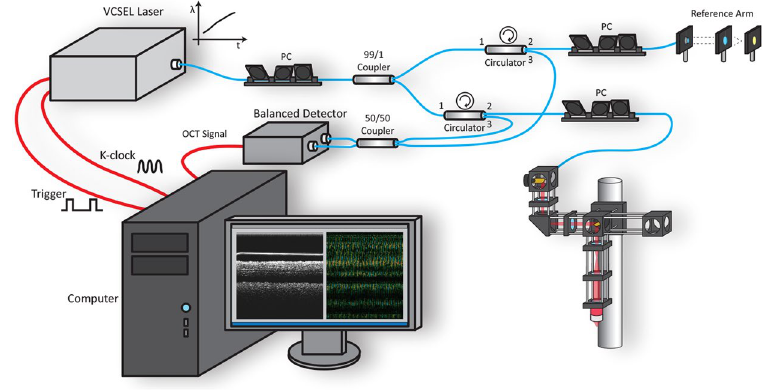
Figure 1. High resolution OCT system